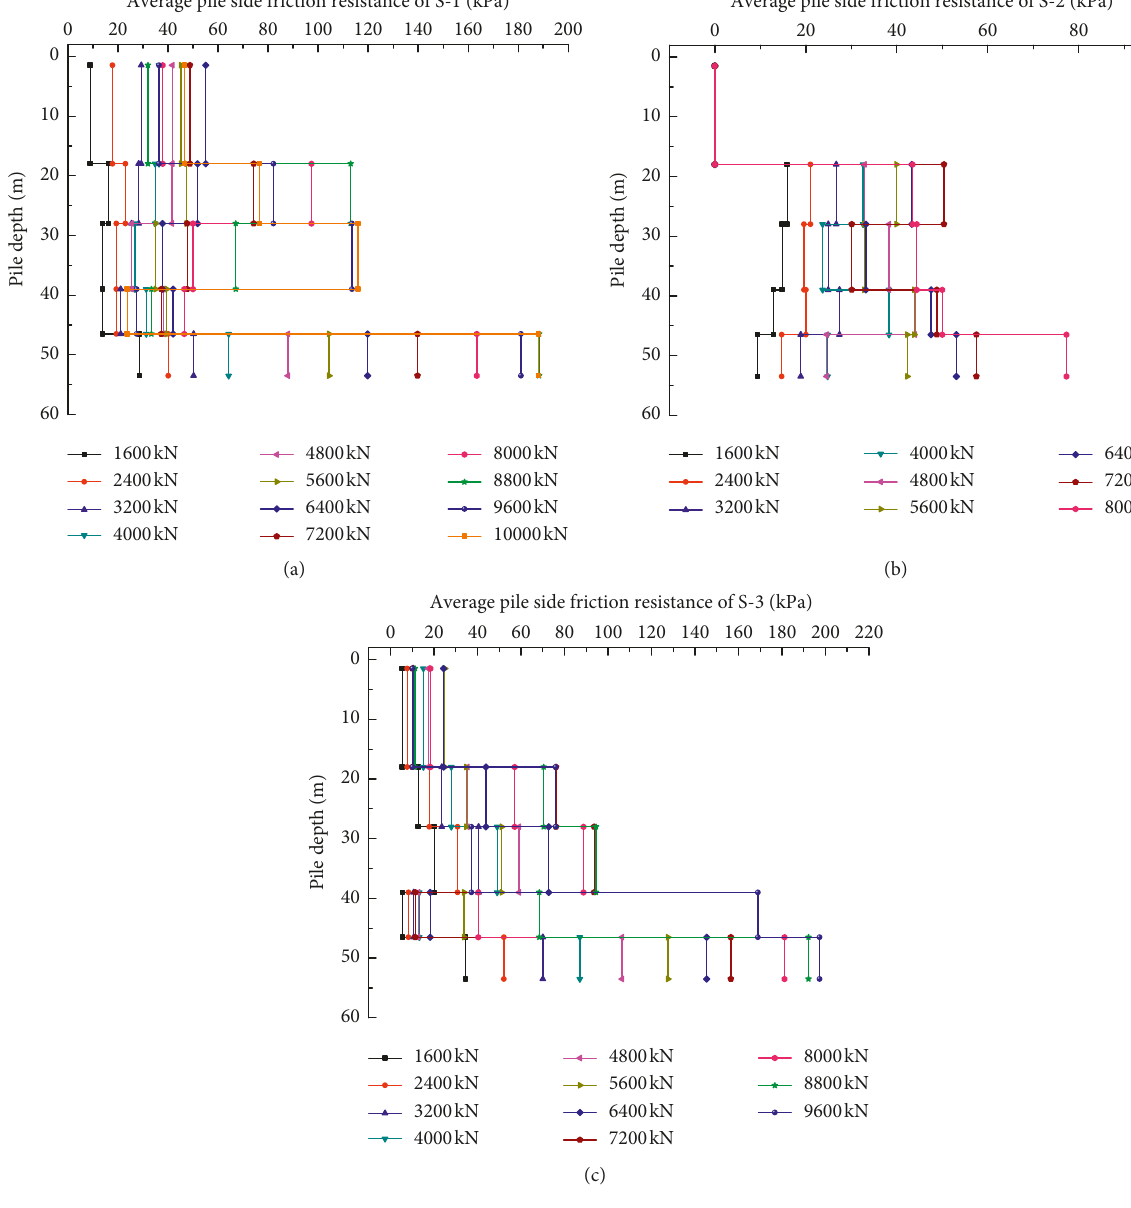
Figure 6: Distributions of average pile shaft